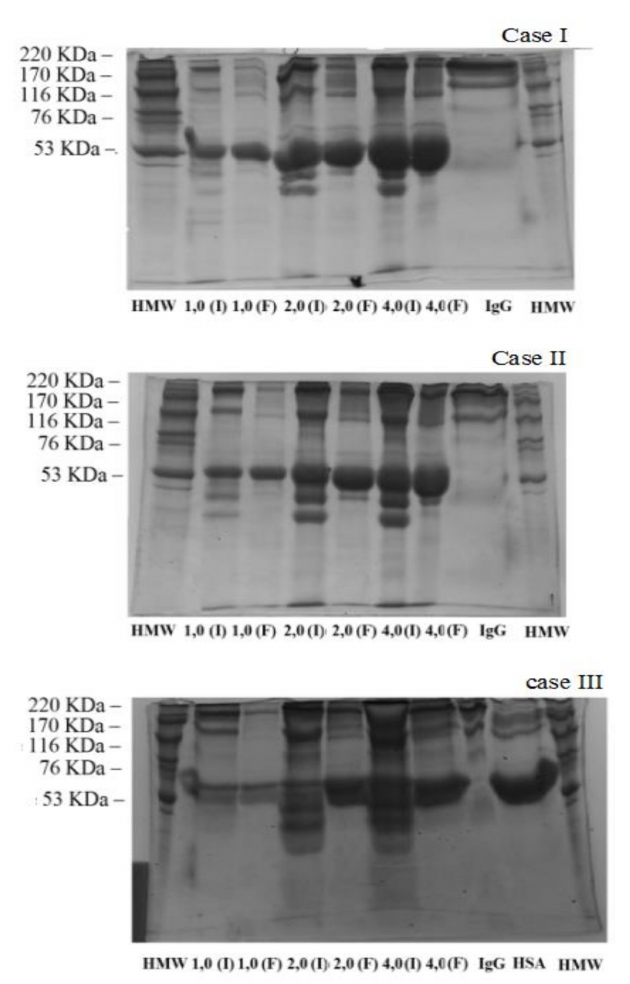
Figure 6. SDS–PAGE analysis of samples before and after adsorption batch experiments with binary solution diluted in Tris/HCl at pH 9.0 revealing with Coomassie brilliant blue for all. HMW (molecu- lar weight marker: Myosin (220 KDa), α -macroglobulin (170 KDa), β -Galactosidase (116 KDa), trans- ferrin (76 KDa) e Lutamic Dehidrogenase (53 KDa)), I (initial concentrations: 1.0, 2.0, 4.0 mg mL − 1 ), F (final concentrations: 1.0, 2.0, 4.0 mg mL − 1 ), IgG (IgG standard), HSA (HSA